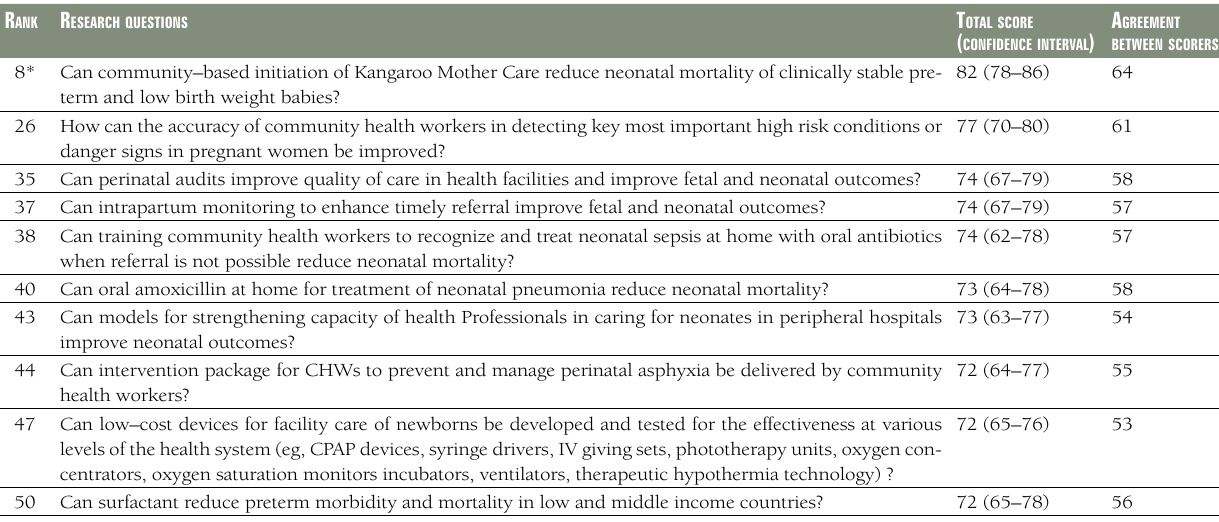
Table 2. Top ten development research priorities for improving newborn health and birth outcomes by 2025 as ranked by 91 experts R ank R eseaRch